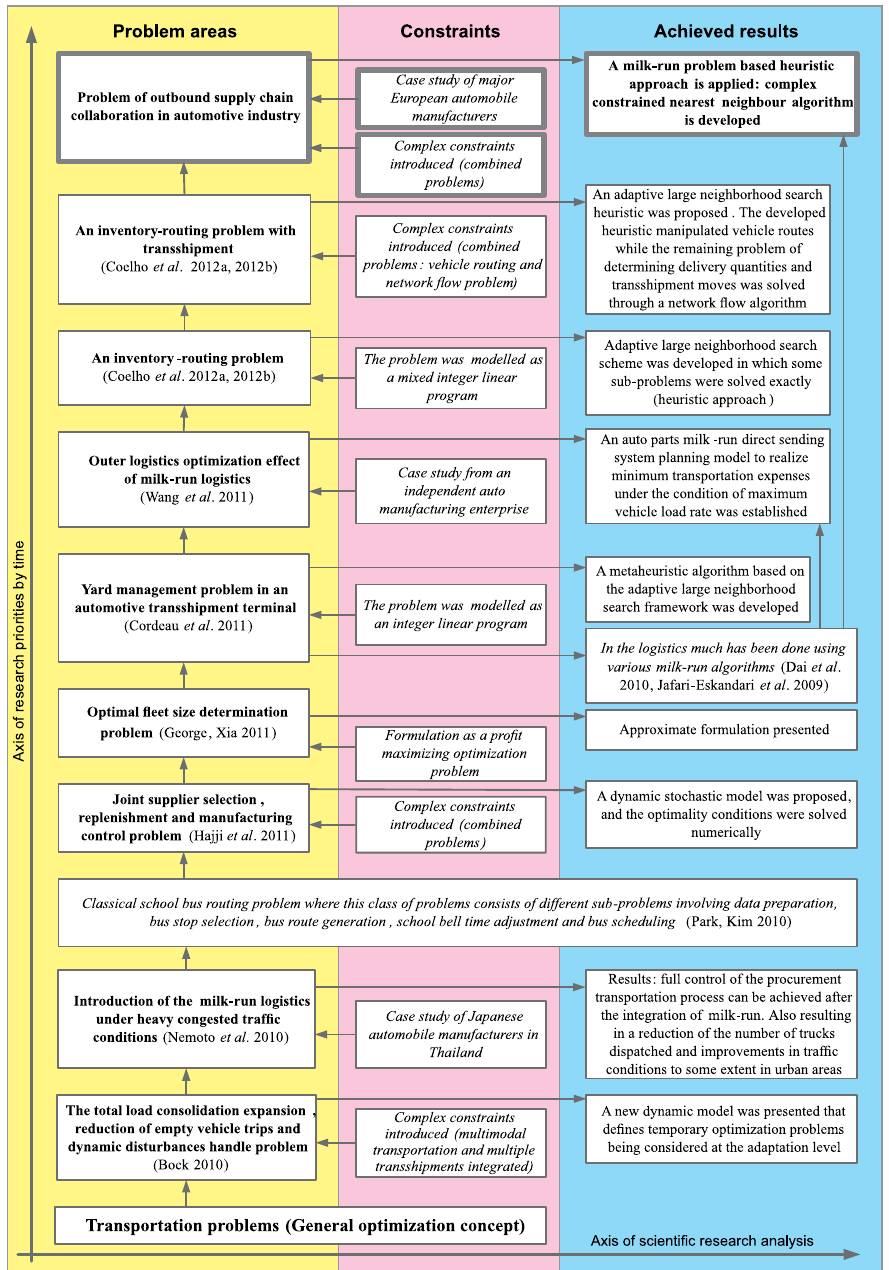
Fig. 1. Overview of solution methods of specific transport